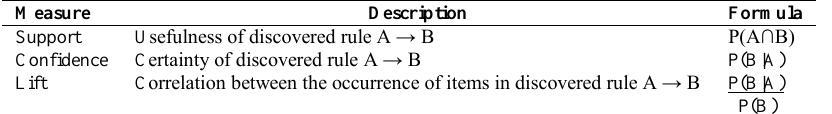
Table 7. Summary of definitions along with formula of three measures [45].